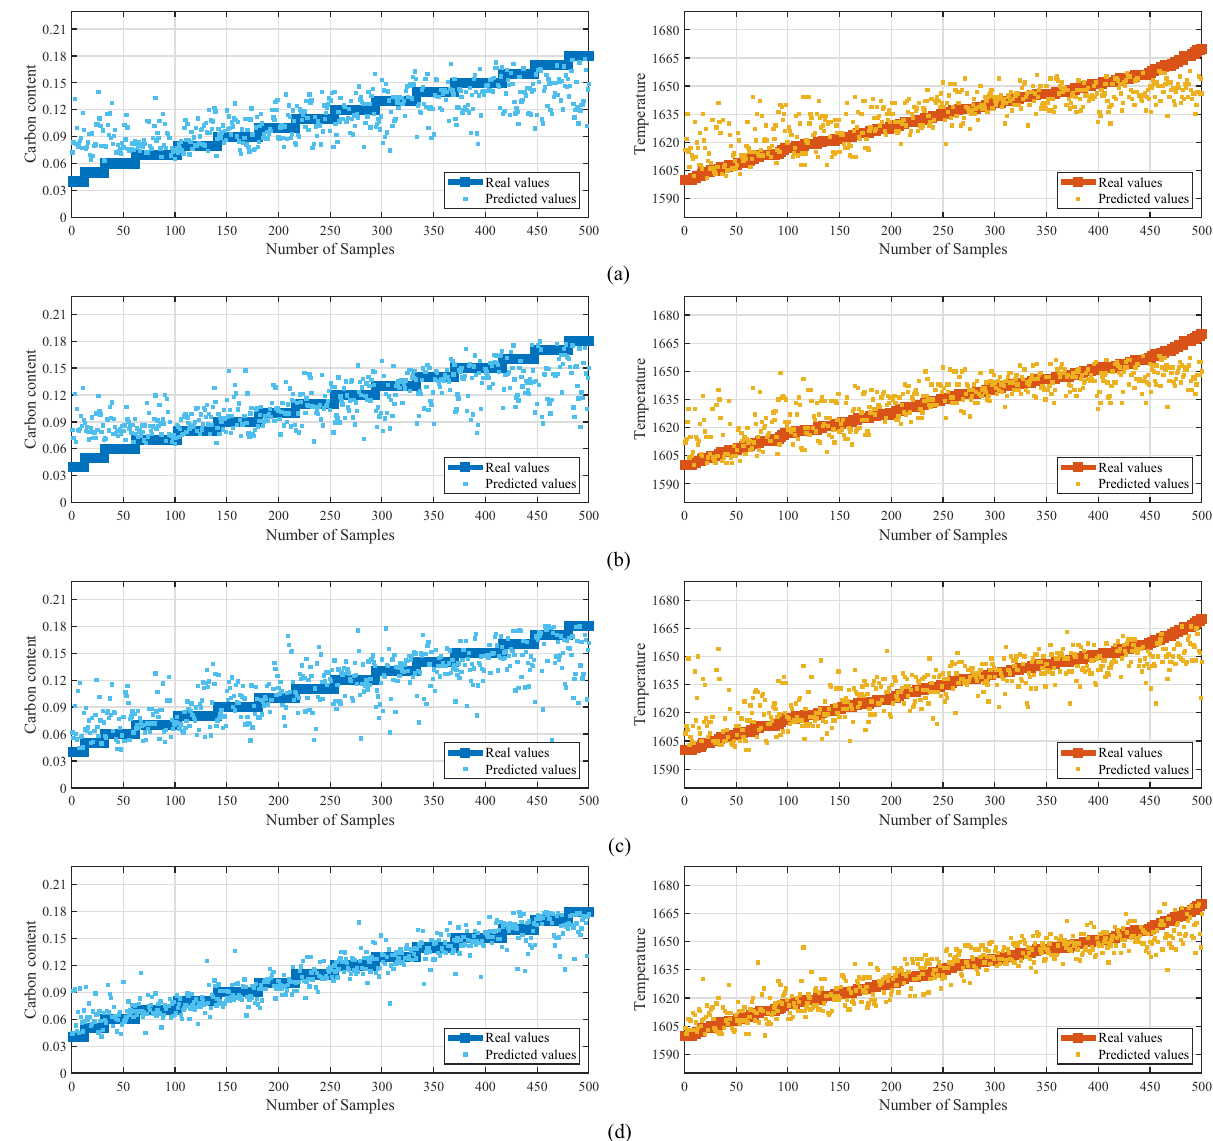
Figure 10: Scatter plots of actual and predicted values for carbon content ( left ) and temperature ( right ) : ( a ) VW - SAE, ( b ) NVW - SAE, ( c ) SQAE, and ( d ) vMF -